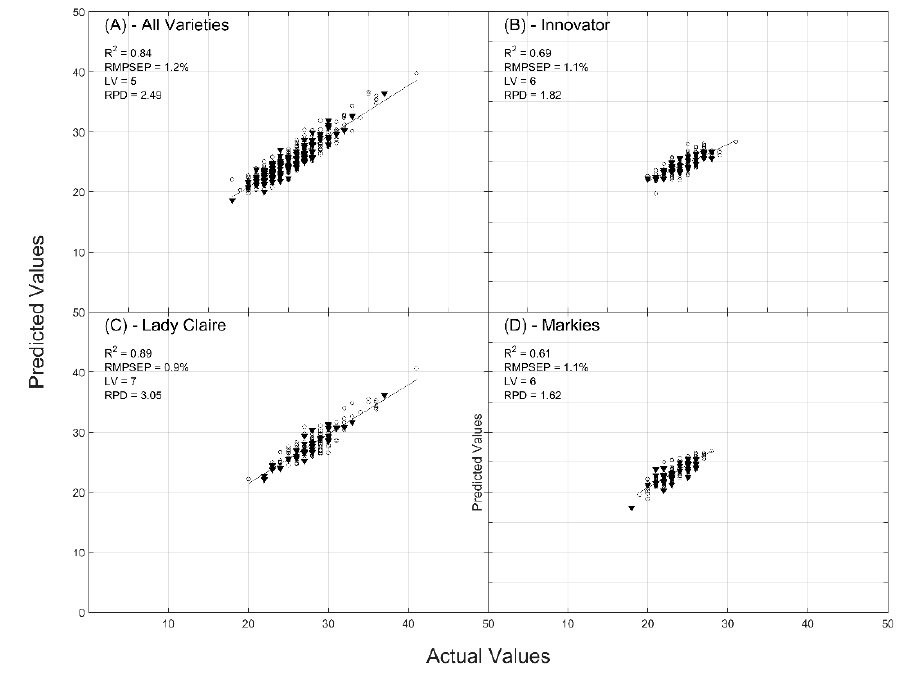
Figure 1. Actual vs. predicted values of dry matter content (DMC) (g of dry weight/100 g fresh weight). Calibration ( ○ ), validation ( ▲ ). A : Entire and peeled tubers of the three tested varieties, B : Entire and peeled tubers of Innovator, C : Entire and peeled tubers of Lady Claire, D : Entire and peeled tubers of Markies.